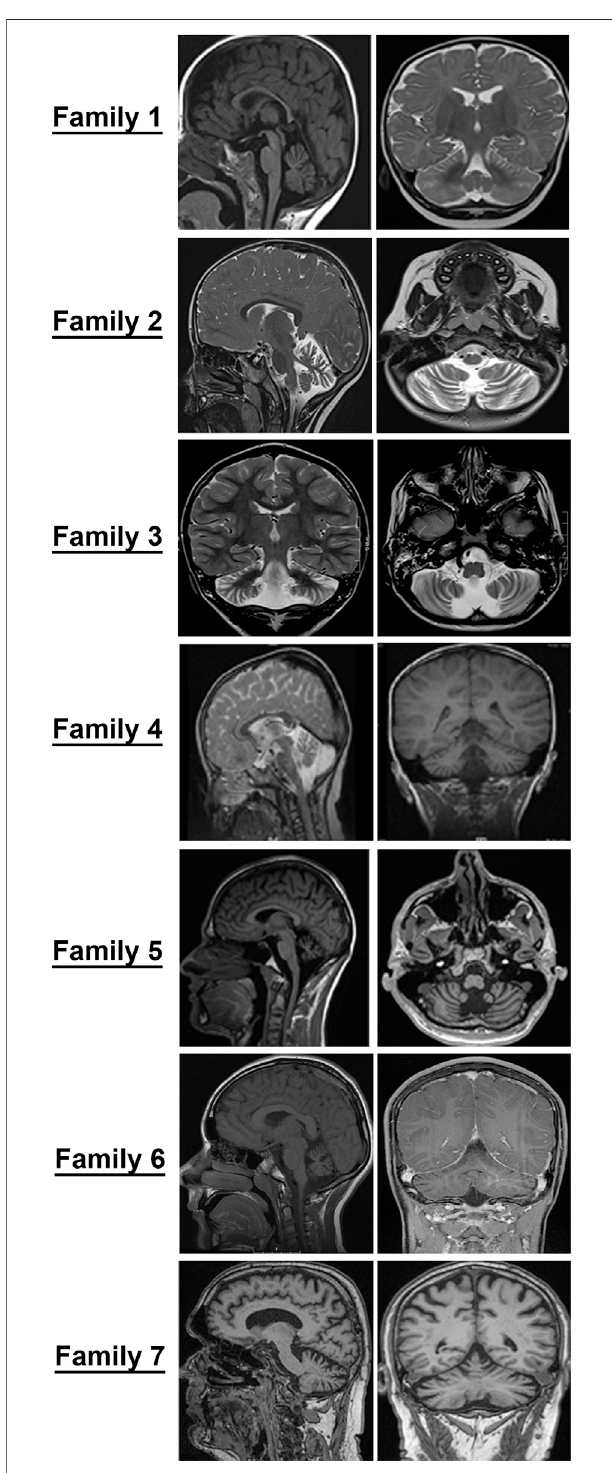
FIGURE 2 | Cerebellar atrophy is a common feature among all individuals with GEMIN5 -associated disease. Magnetic resonance imaging (MRI) of probands from families identi fi ed in the present study. Midsagittal, coronal,and axialT2/T1imagesshowingevidenceofcerebellar atrophy, which was present in all